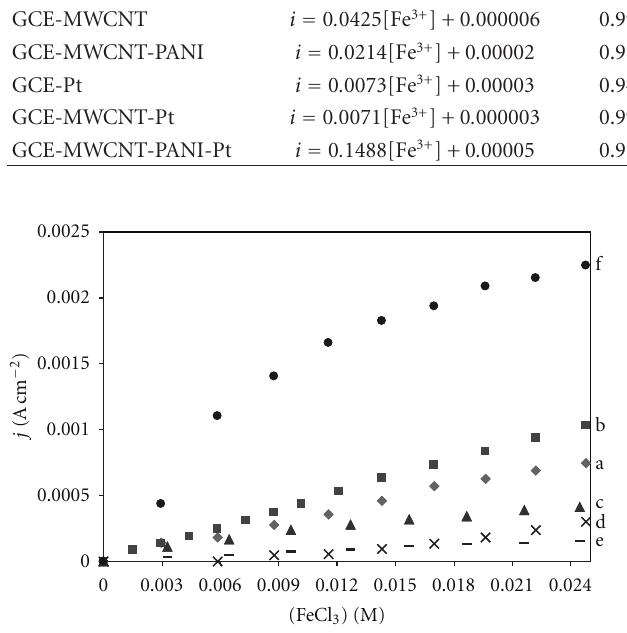
Figure 2: Calibration curves of ionic iron electroreduction over: GCE (a), GCE-MWCNT (b), GCE-MWCNT-PANI (c), GCE-Pt (d), GCE-MWCNT-Pt (e), and GCE-MWCNT-PANI-Pt (f) in 0.1 M KCl at